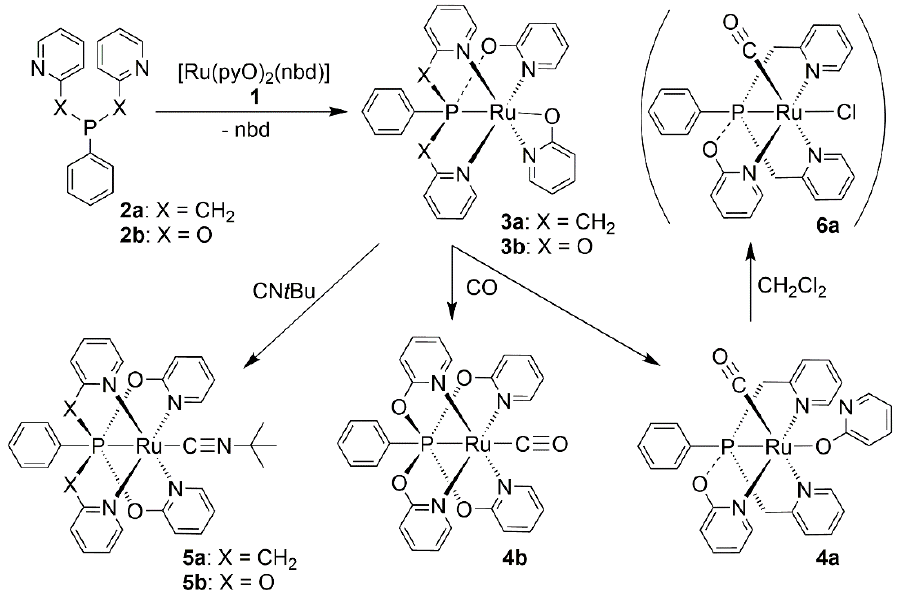
Scheme 2. Syntheses of the compounds under investigation.